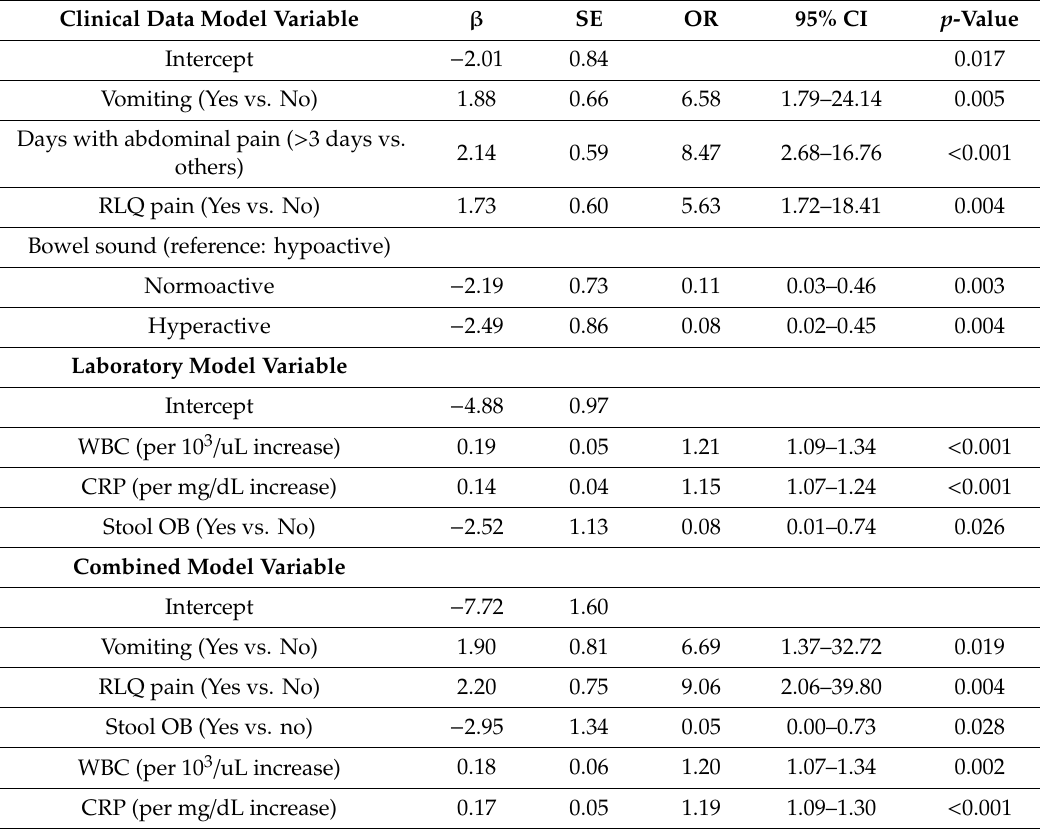
Table 3. Multivariable stepwise logistic regression of the laboratory model, clinical data model, and combined